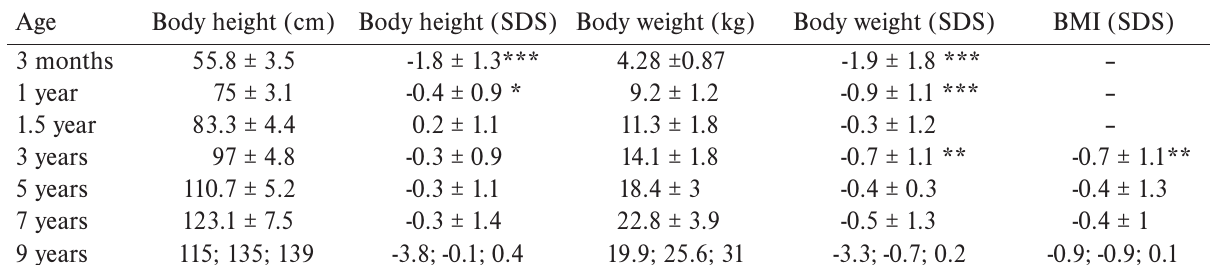
Table 1. Anthropometric data.